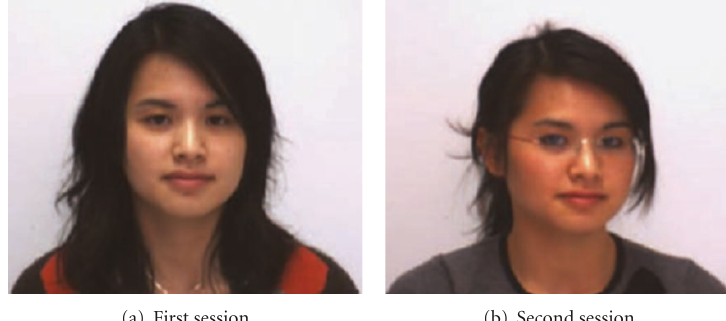
Figure 8: An example of repeat subject.